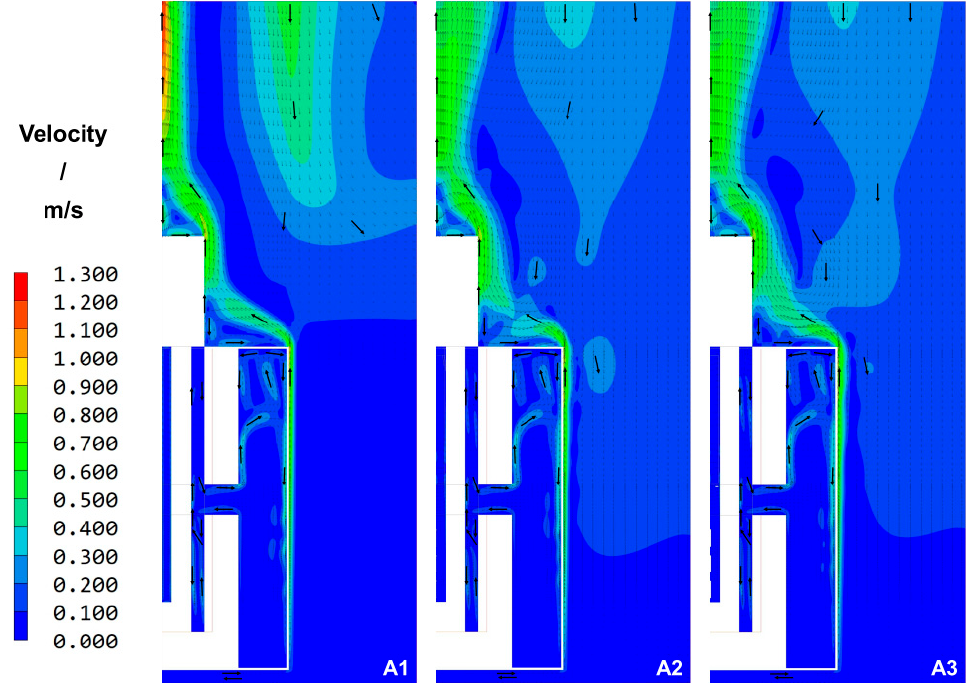
Figure 8. Overview of velocity distribution in the entire domain for cases A1, A2, and A3, respectively. For better visibility, thick arrows were added as guides to the eye.